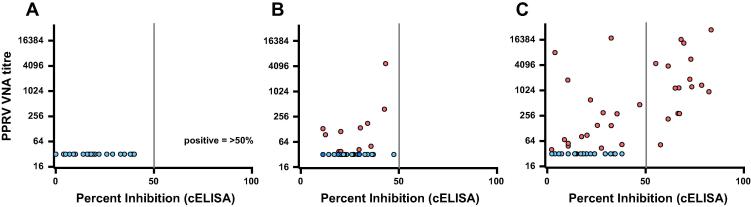
PPRV neutralising antibodies in sera from Tanzanian ruminants. Sera from (A) gazelle (n = 27), (B) buffalo (n = 42) or (C) goats (n = 59) were screened by competitive ELISA (cH-ELISA) for anti-PPRV H antibodies and a “percent inhibition” calculated for each sample. The samples were then re-screened for neutralising antibodies against VSV(PPRV) pseudotypes. Serial dilutions of each serum sample were prepared in triplicate and screened for neutralising activity against VSV(PPRV) pseudotypes (Nigeria/75/1). Antibody titres were calculated based on a 90% reduction of infectivity relative to the no serum control. Samples which tested negative for neutralising antibodies are shown in blue, those which tested positive for PPRV neutralising antibodies are highlighted in red. The 50% cut-off above which a sample is declared positive by the cH-ELISA is denoted by a grey line. (For interpretation of the references to color in this figure legend, the reader is referred to the web version of this article.)